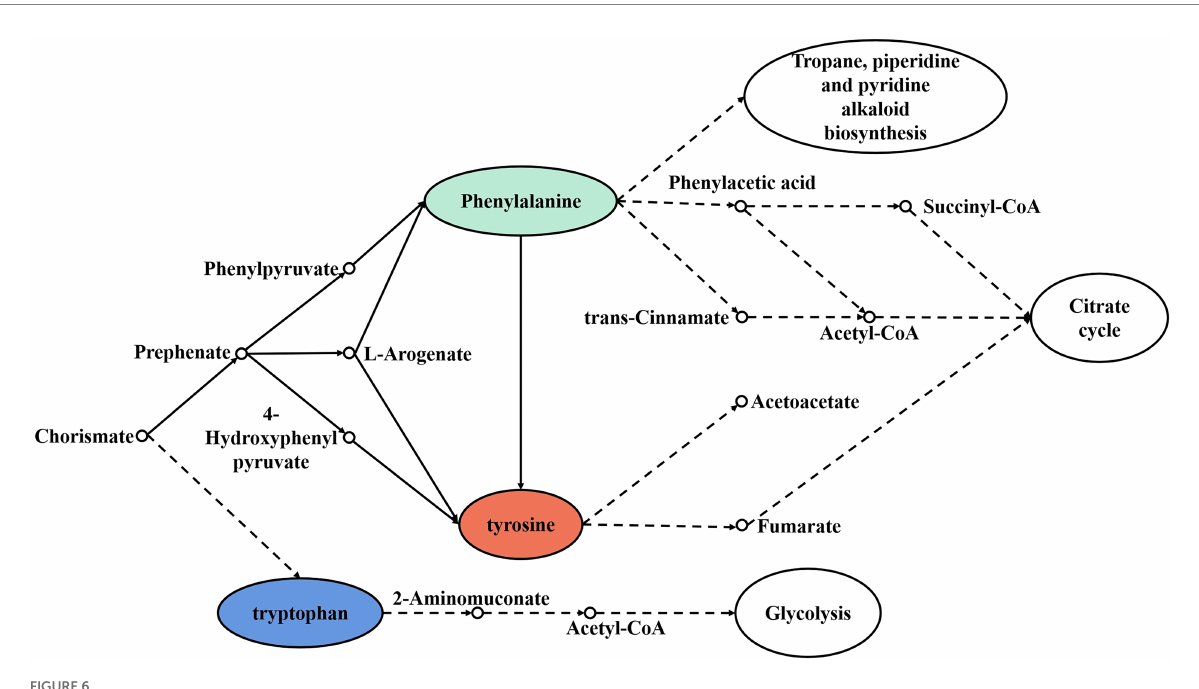
FIGURE 6 Synthesis and metabolic pathway of aromatic amino